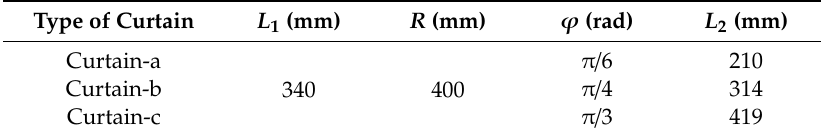
Figure 4. Shape and the geometric parameters of the straight-arc curtain ( θ = 90°). Table 1. The parameters of the